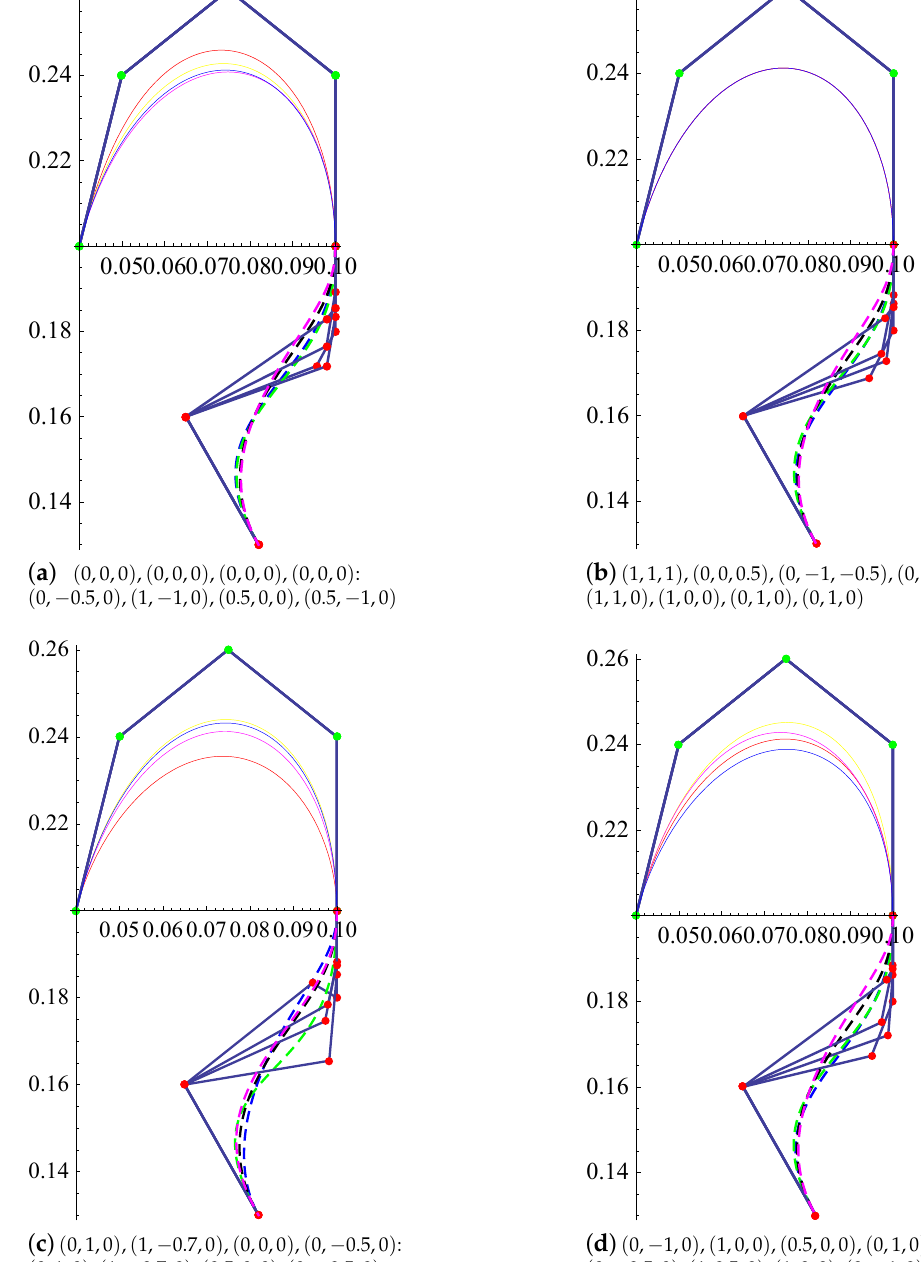
Figure 9. G 2 smooth continuity of the GHT-Bézier curve with various shape parameters. ( a ) ( 0,0,0 ) , ( 0,0,0 ) , ( 0,0,0 ) , ( 0,0,0 ) : ( 0, 0.5,0 ) , ( 1, 1,0 ) , ( 0.5,0,0 ) , ( 0.5, − − ( 0, 1, 0.5 ) , ( 0,0,0 ) : ( 1,1,0 ) , ( 1,0,0 ) , ( 0,1,0 ) , ( 0,1,0 ) ; ( c ) ( 0,1,0 ) , ( 1, − − ( 0,1,0 ) , ( 1, 0.7,0 ) , ( 0.5,0,0 ) , ( 0, 0.5,0 ) ; ( d ) ( 0, 1,0 ) , ( 1,0,0 ) , ( 0.5,0,0 ) , ( 0,1,0 ) : ( 0, − − − ( 1,0.5,0 ) , ( 1,0,0 ) , ( 0, 1,0 ) −